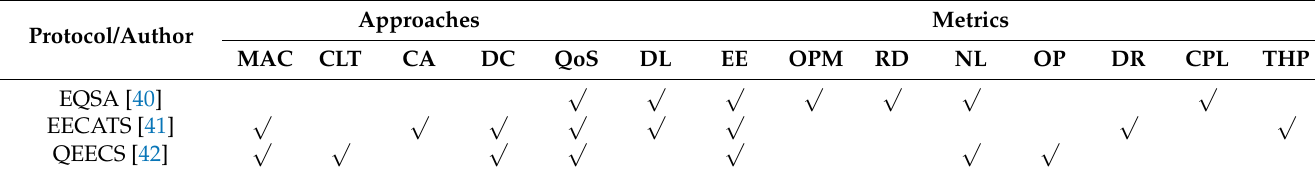
Table 9. Comparative assessment of energy efficient scheduling